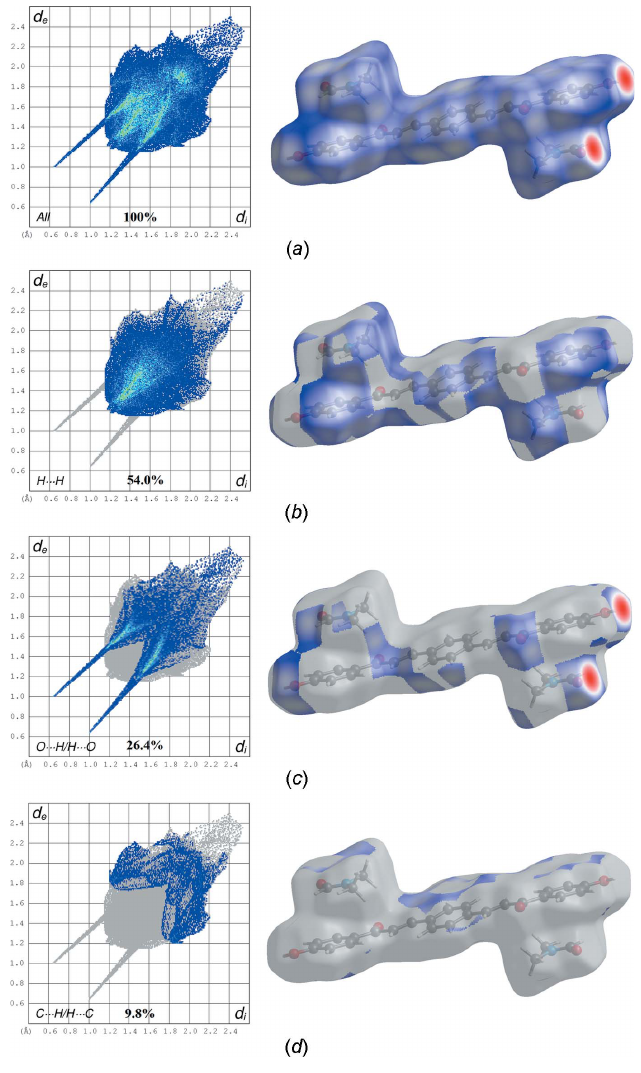
Figure 5 The two-dimensional fingerprint plots for the title compound showing contributions from different contacts; the views on the right highlight the relevant surface patches associated with the specific contacts.